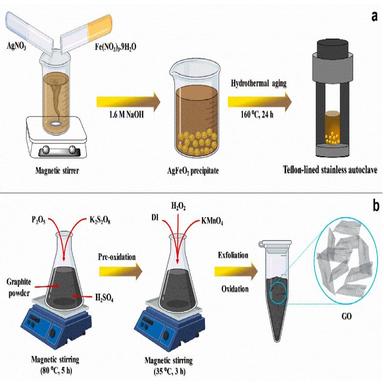
Schematic representing the brief synthetic method adopted for (a) AgFeO2 and (b) GO.